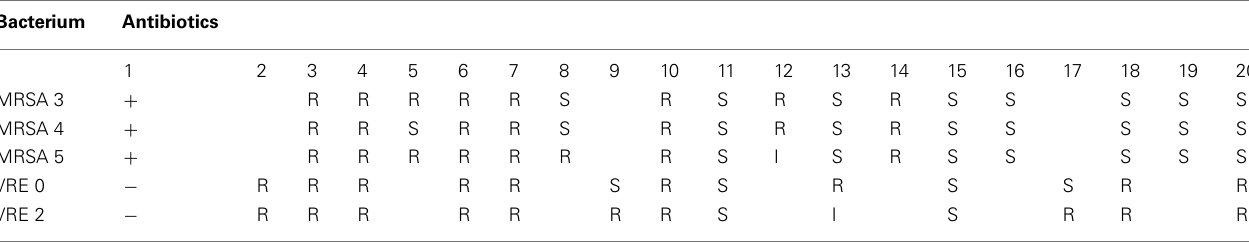
Table 2 | Susceptibility of clinical isolates to antibiotics.